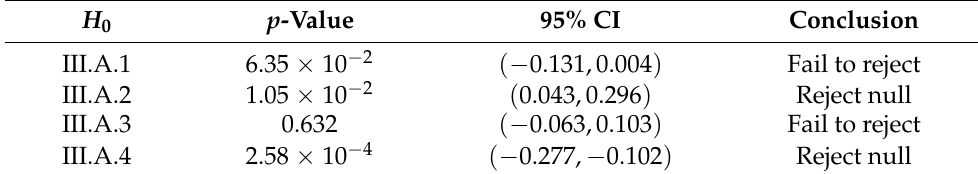
Table 3. Summary of two-tail t -test performed for baseline and treatment tests. Hypothesis III.A.4 is a paired t